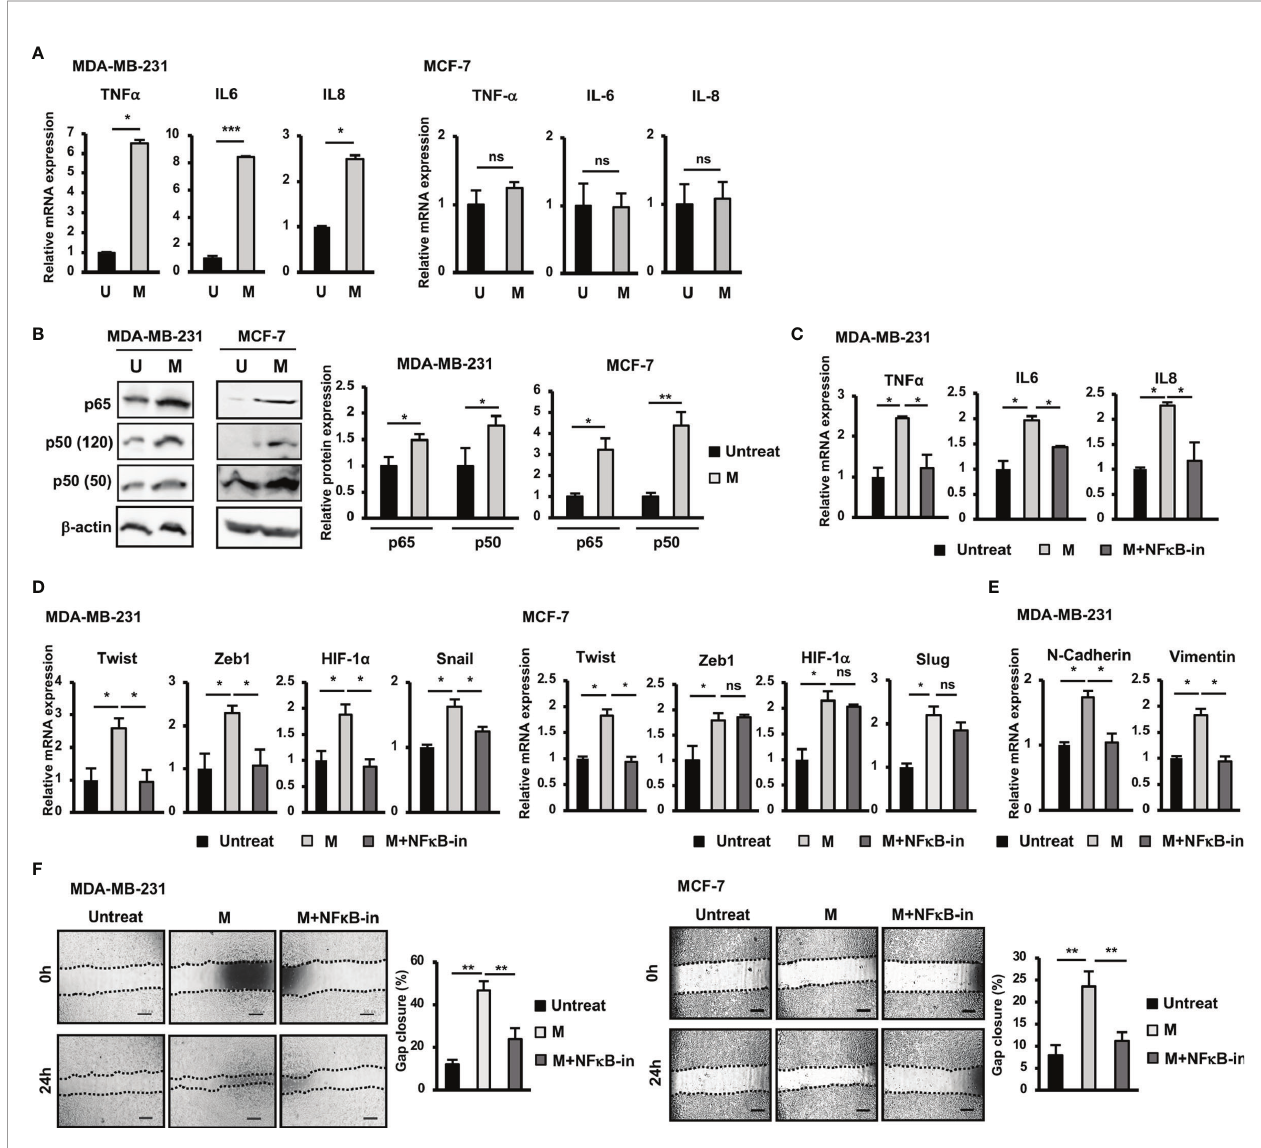
FIGURE 2 | NF k B pathway was involved in the upregulation of EMT genes and the induction of migration of BCC by SARS-CoV-2 M protein. (A) Gene expression of in fl ammatory cytokines in BCC treated with M protein. (B) Protein expression of p65 and p50 in BCC treated with M protein. (C) The mRNA expression of in fl ammatory cytokines in BCC in the presence of M protein and NF k B inhibitor. (D) The mRNA expression of genes related to EMT process in BCC in the presence of M protein and NF k B inhibitor. (E) The mRNA expression of EMT markers in MDA-MB-231 cells treated with M protein in the presence of NF k B inhibitor. (F) Migration of BCC treated with M protein in the presence of NF k B inhibitor. BAY11-7082 10 m M was used as NF k B inhibitor. U, untreated BCC; M, M protein-induced BCC. The scale bars indicate 500 µm. Each value represents the mean ± SD of triplicate experiments. (ns, no signi fi cance; p > 0.05; *p ≤ 0.05; **p ≤ 0.01; ***p ≤